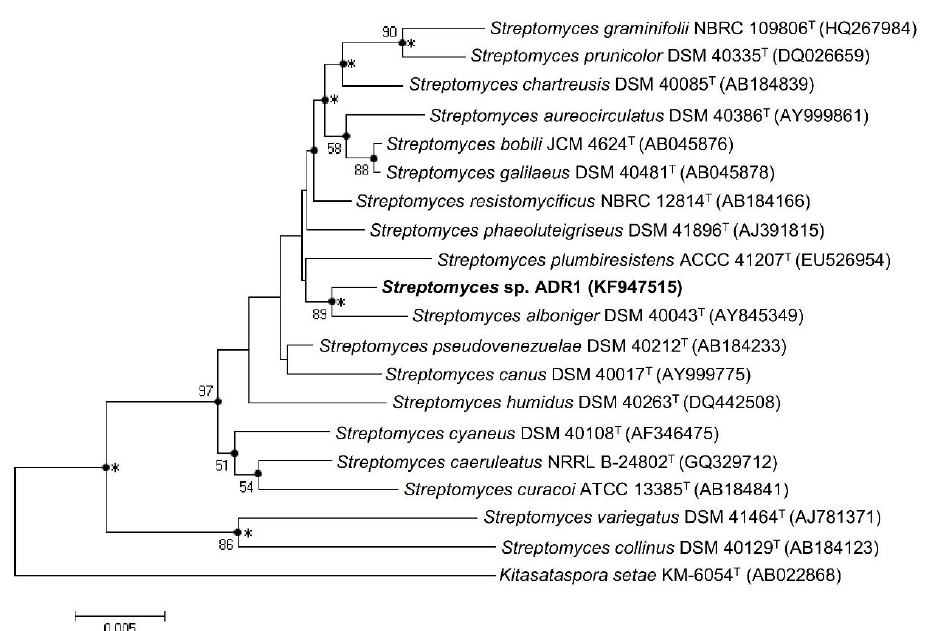
Figure 2. Neighbor-joining tree based on 16S rRNA gene sequences, showing relationships between Streptomyces sp. ADR1 strain and related strain types of the genus Streptomyces . Only bootstrap values above 50% (percentages of 1000 replications) are indicated. Branches marked with a solid circle were also recovered in the maximum-likelihood tree; asterisks show branches recovered in the maximum-parsimony tree. Bar, 0.01 substitutions per nucleotide position. * show branches recovered in the maximum-parsimony tree.